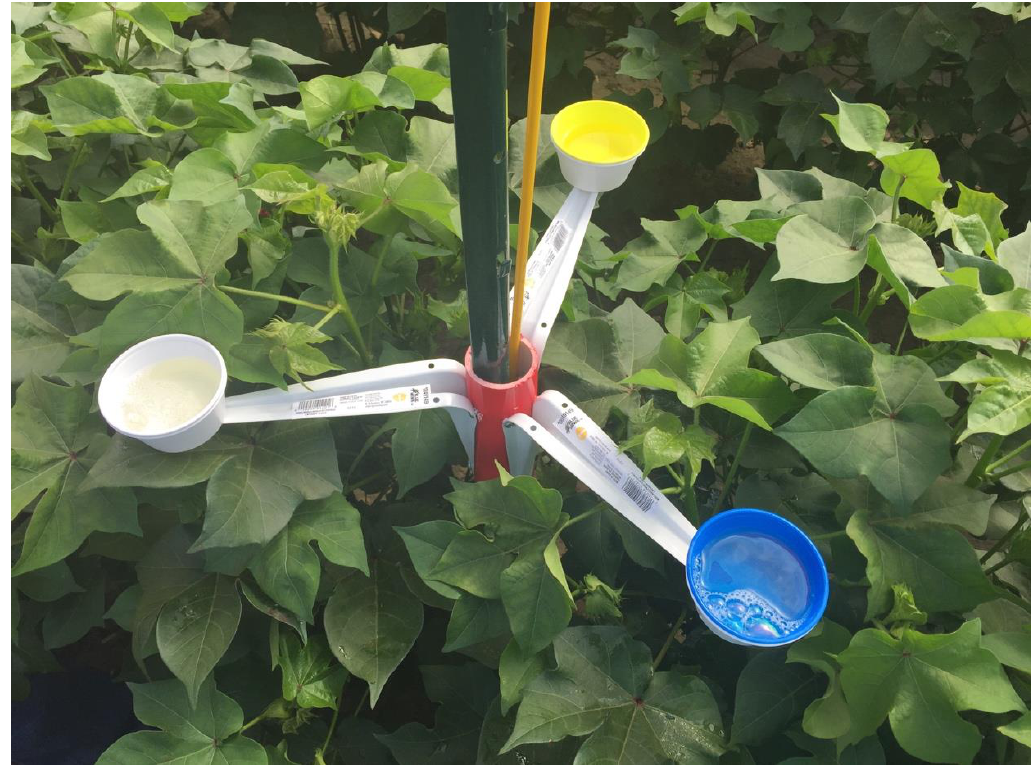
Figure 1. Example of modified pan traps, also called bee bowls, placed in a cotton field.